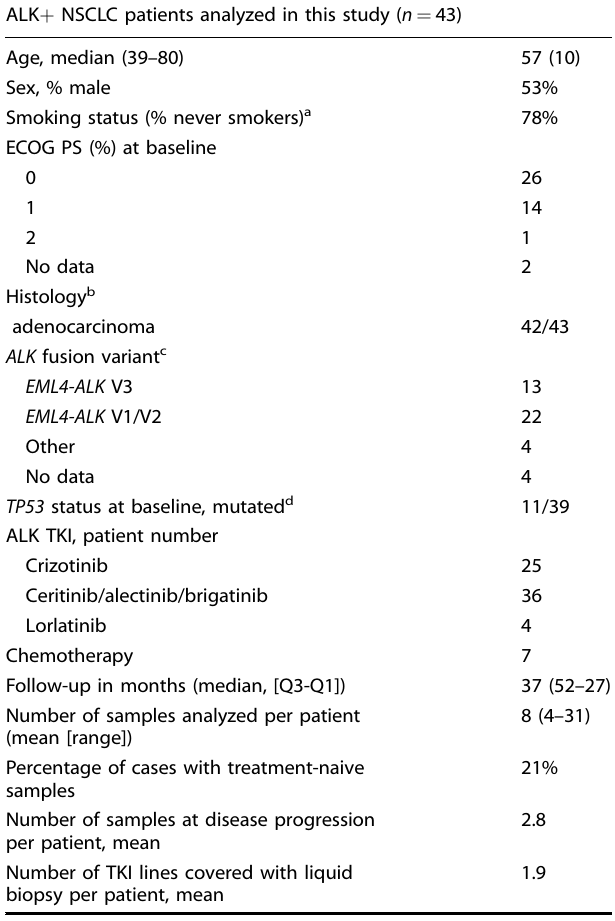
Table 1. Patient